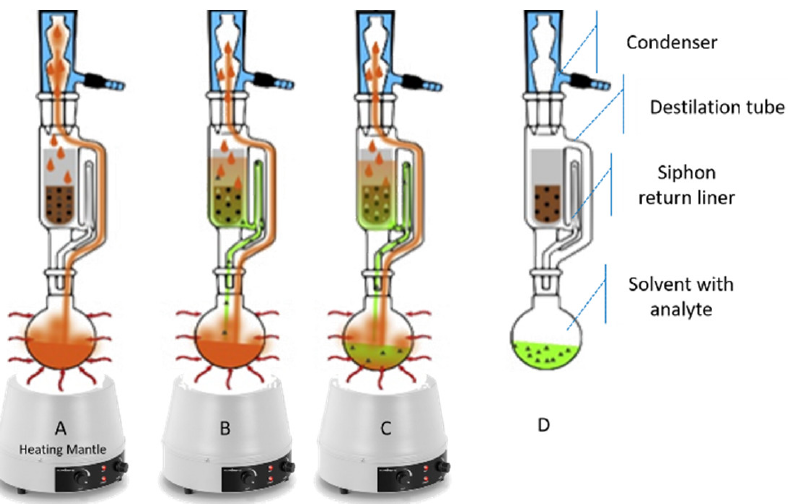
Figure 6. Schematic illustration of the workflow of SOX. Adapted from Weggler et al. [116]. ( A ) The solid matrix is placed in SOX thimble and the solvent is heated under reflux; ( B ) Solutes are transferred from the extraction chamber into the reservoir; ( C ) Continuous repetition of the extraction occurs; ( D ) Exhaustive extraction is complete. solutions. Escobar-Avello et al. [118] worked with grape canes (vine shoots), a viticultural by-product containing high levels of phenolic compounds. They used grape canes of Vitis vinifera cv. Pinot noir, and a 750 L pilot-plant reactor under the following conditions: T = 80 ◦ C, time 100 min, solid/liquid ratio 1:10. The extraction solvent was constituted by ethanol: water solution (80:20, v / v